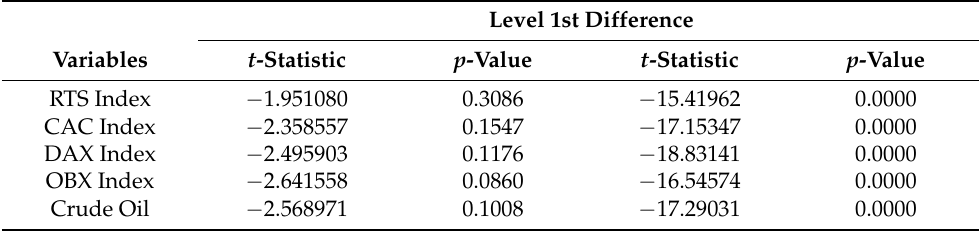
Table A3. Augmented Dickey–Fuller Test Results (Post-Vaccine